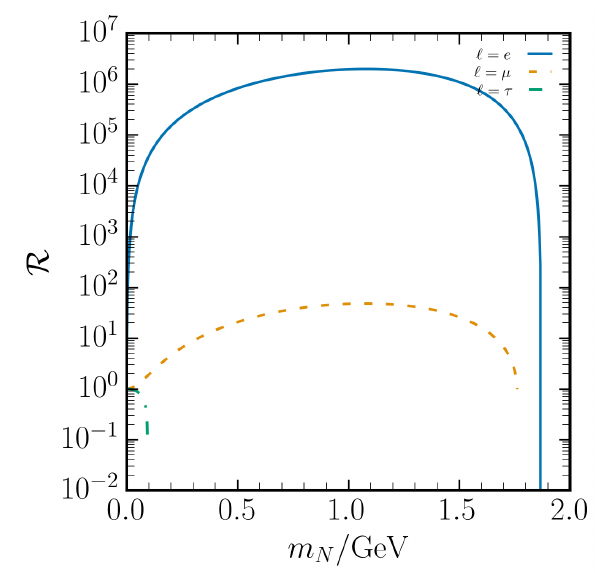
Figure 3: The enhancement of HNL production relative to massless neutrinos in two- body meson decays (8). For HNLs mixing with the electron or muon neutrino, there is significant enhancement due to relaxation of the helicity suppression as the HNL mass increases. However for HNLs mixing with the tau neutrino the enhancement is negligible; this explains why no bound was quoted in the previous BEBC analysis [ 23 ]